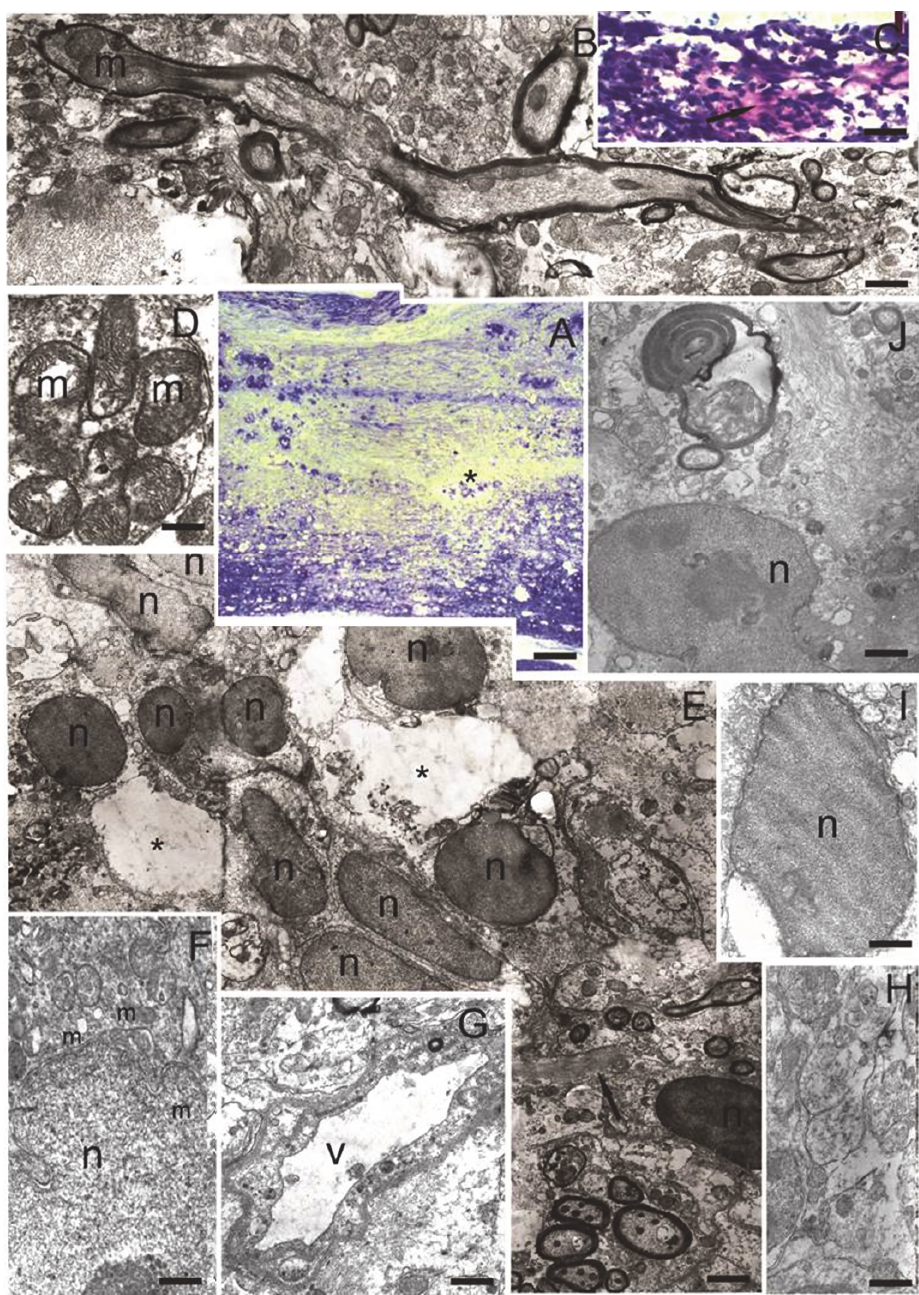
Figure 4: The morphological and ultrastructural features of the spinal cord tissue at day 30 after SCI and transplantation of hUCB-MCs + Ad5-VEGF + Ad5-GDNF. ( 0 ) Longitudinal section of the spinal cord (azure-eosin stain). Asterisk shows small posttraumatic cavities. (B) Myelinated fiber with growth cone contained mitochondria, which are greatly enlarged in size. (C) Red-purple precipitate reveals the presence thin bundles of collagen fibers in the epicenter of injury (arrow). (D) Accumulation of mitochondria with clear cristae in a cross section of unmyelinated fibers. (E) Accumulation of two cell types in the area of injury. Asterisks show small posttraumatic cavities. Arrow indicates process of fibrous astrocyte contained bundles of parallel extending intermediate filament. (F) Astrocyte with cytoplasm rich in next organelles: Golgi complex, mitochondria, multivesicular bodies, and greatly enhanced, almost circular, cisterns of rough endoplasmic reticulum. The boundaries of cell are unclear; processes come between the surrounding fibers. (G) Blood capillaries in the area of injury. (H) Unmyelinated nerve fibers in the area of injury. (I) Microglia in posttraumatic cavity. The nucleus occupies most of the cytoplasm and contains euchromatin. (J) Fibrous astrocyte with electron-transparent cytoplasm and electron-light nucleus with irregular shape. Processes of these cells contained bundles of parallel extending intermediate filament and come between regenerating and degenerating nerve elements. Scale bar: 200 𝜇 W ( 0 ), 5 𝜇 W ( j , E), 100 𝜇 W ( b ), 500 nm (D, F, H), 1 𝜇 W (G), and 3 𝜇 W (I, J). m: mitochondria; n: nucleus; v: